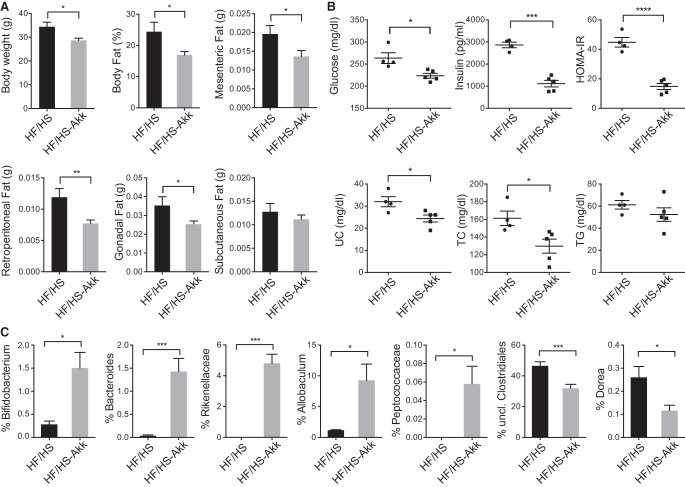
Akkermansia muciniphila treatment reduces obesity and metabolic syndrome traits in mice fed a HF/HS diet. (A) Total body weight, body fat, mesenteric, retroperitoneal, gonadal, and subcutaneous fat depot weights (g per 100 g body weight) in mice treated by oral gavage with live or heat-inactivated A. muciniphila and fed a HF/HS diet (n = 5). (B) Glucose, insulin, HOMA-IR, unesterified cholesterol (UC), total cholesterol (TC), and triglycerides (TG) levels. (C) Relative abundance of bacterial genera between different treatment groups. Data are shown as means ± SD. Significant differences: (*) P < 0.05, (**) P < 0.01, (***) P < 0.001, (****) P < 0.0001, with unpaired two-tailed Student's t-test.